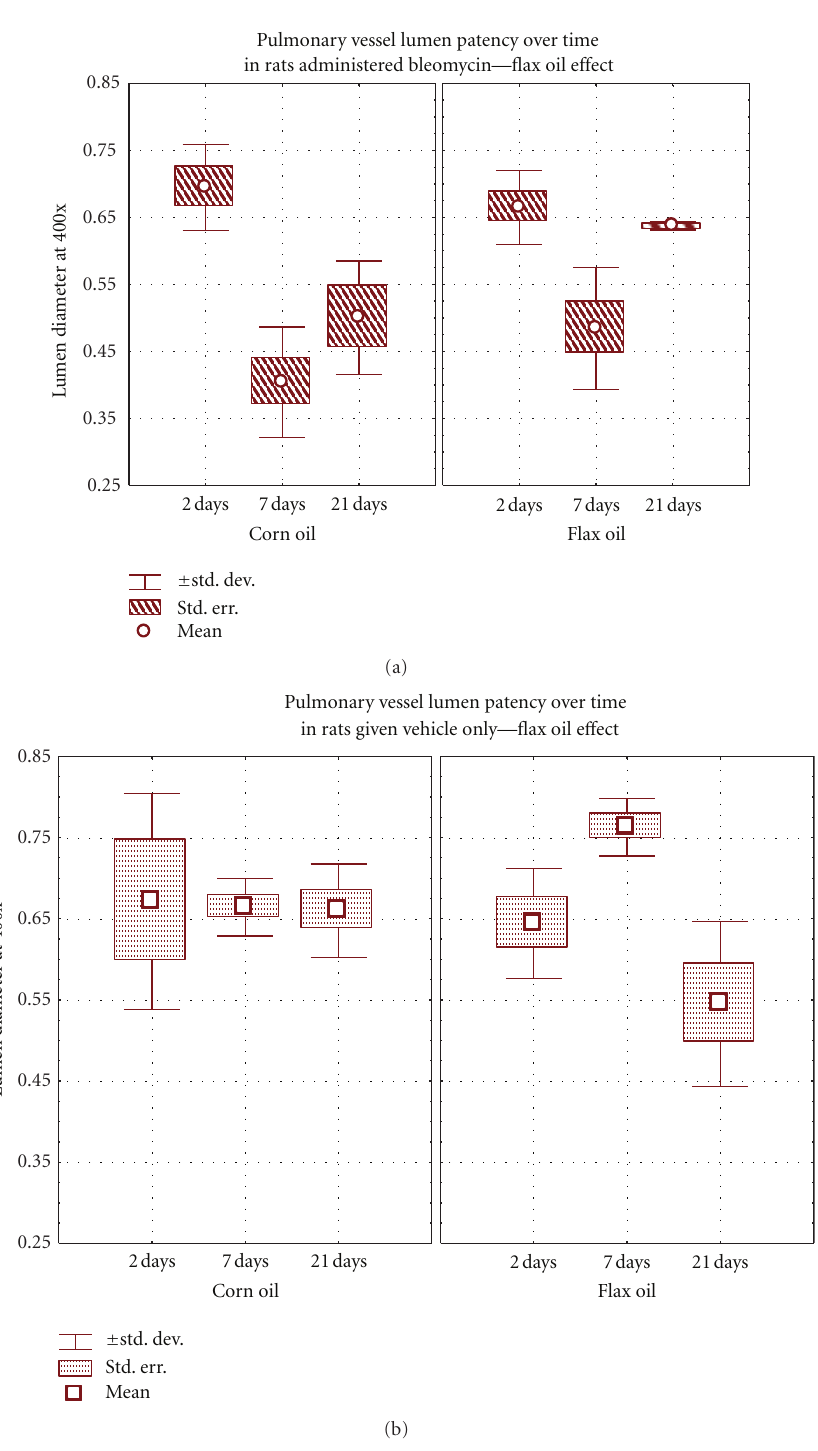
Figure 5: Lumen patency of small caliber pulmonary arteries and arterioles of the four groups at each time interval point. BC-treated rats show marked wall thickening and reduced lumen patency at day 7 and 21. No significant di ff erences were observed in the lumen patency of arteries of rats instilled with the vehicle. The symbols represent means, boxes represent standard error, and the whiskers represent standard deviation